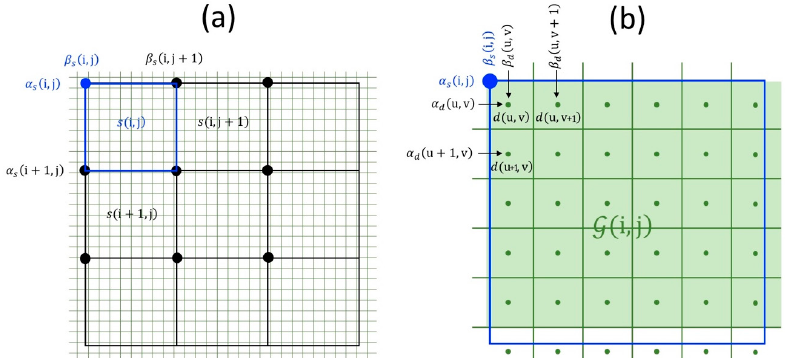
Figure 3. ( a ) Ordered grid of pixels s ( i,j ) belonging to satellite tile S , located at latitude and longitude coordinates α s ( i,j ) and β s ( i,j ) ; and ( b ) ordered grid of pixels d ( u,v ) belonging to satellite imagery D , located at α d ( i,j ) and β d ( i,j ) . Selected UAV pixels belonging to G ( i,j ) , used for comparison to satellite pixel s ( i,j ) , are highlighted in light